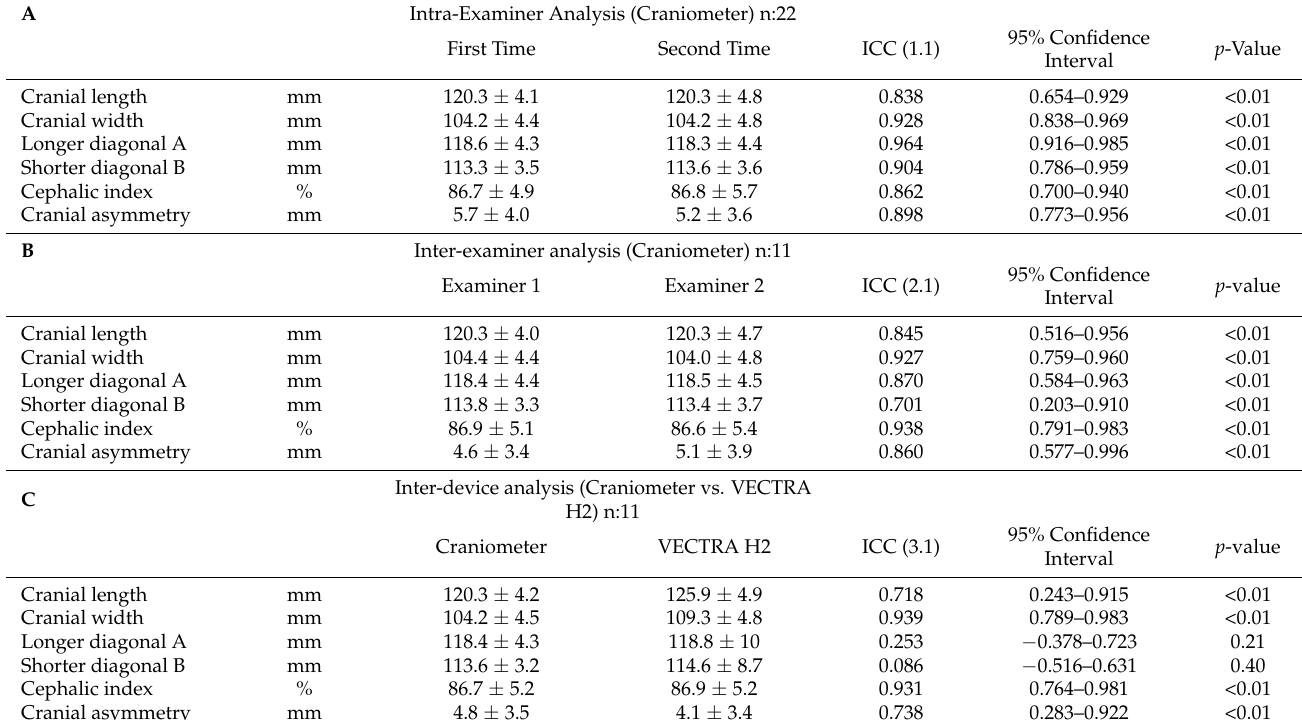
Table 2. Evaluation of inspection accuracy in 1-month-old